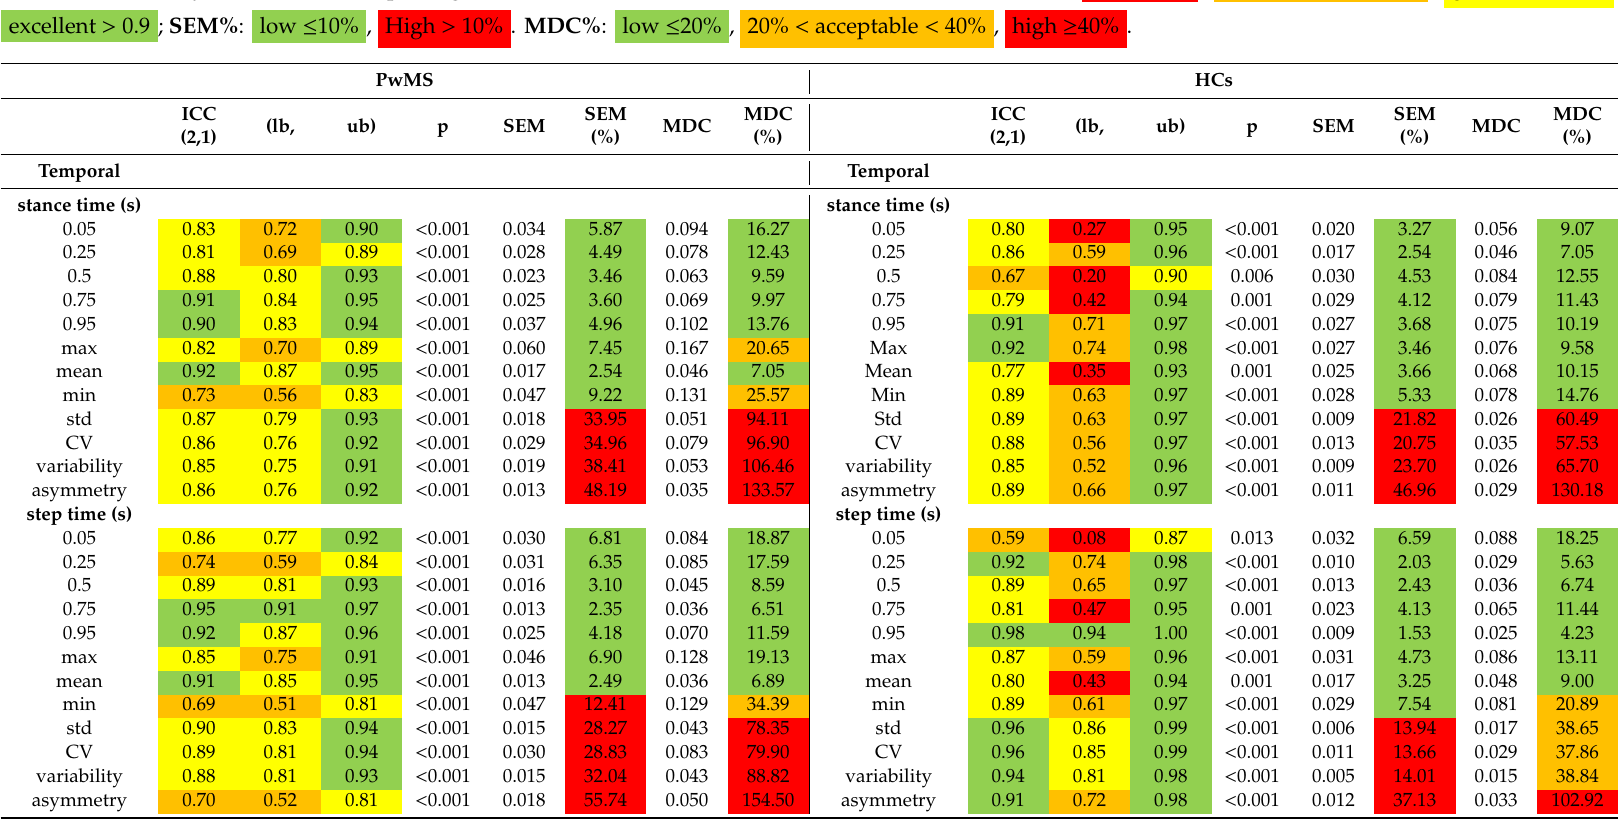
Table 3. Reliability statistics for temporal gait characteristics for PwMS and HCs. Colour code- ICC : Poor < 0.5 , moderate = 0.5–0.75 , good = 0.75–0.9